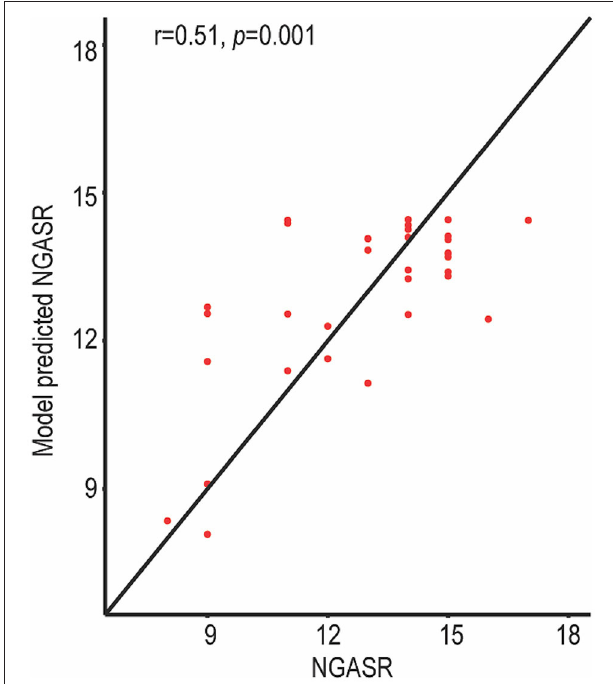
FIGURE 4 | NGASR values estimated using the support vector regression model in SA patients. The predictive performance was evaluated by Spearman correlation between the predicted NGASR values and professionally evaluated NGASR values. The correlation between the predicted NGASR values and the professional NGASR values was